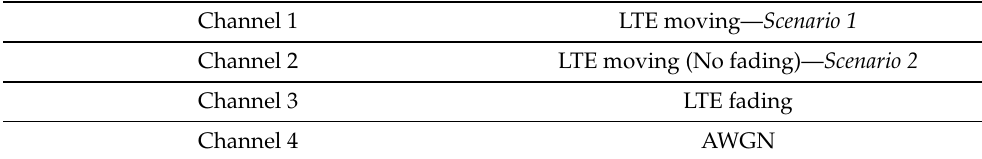
Table A4. The channel conditions for